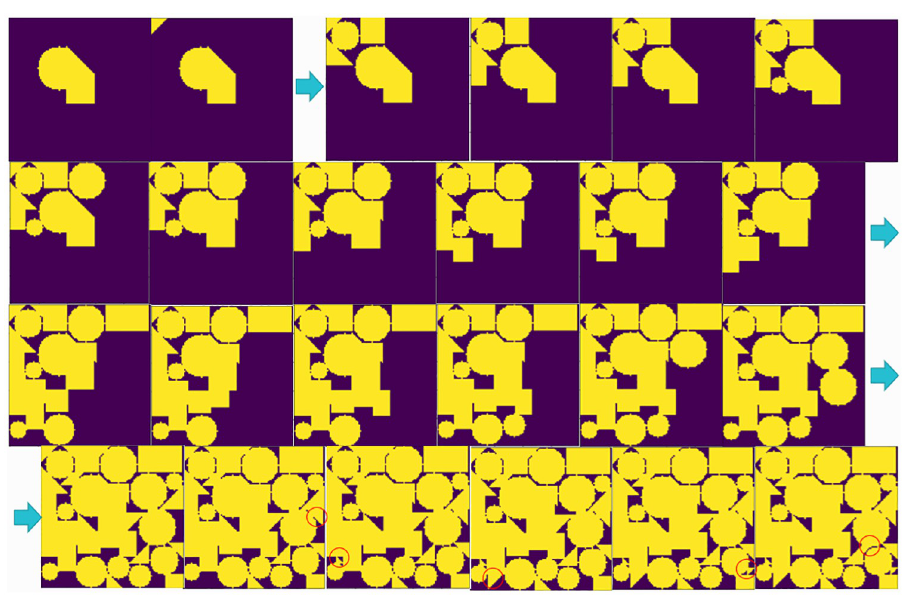
Fig 15. The whole layout process in the non-empty bin. The whole layout process for damaged raw materials.